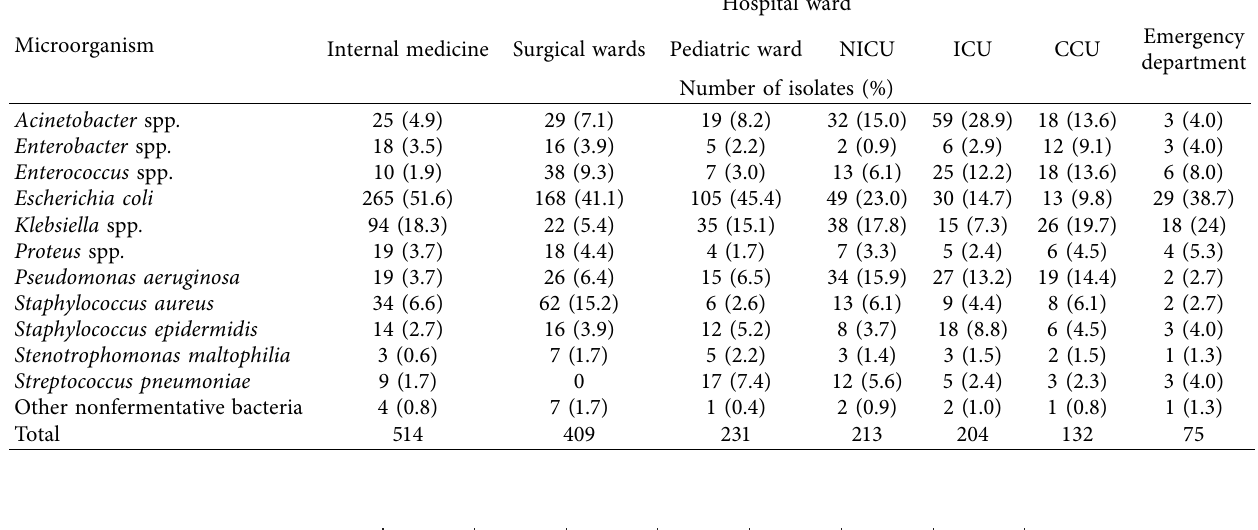
Table 1: Distribution of bacteria isolated from different samples collected from patients with infections. Microorganism Acinetobacter spp . Enterobacter spp . Enterococcus spp .